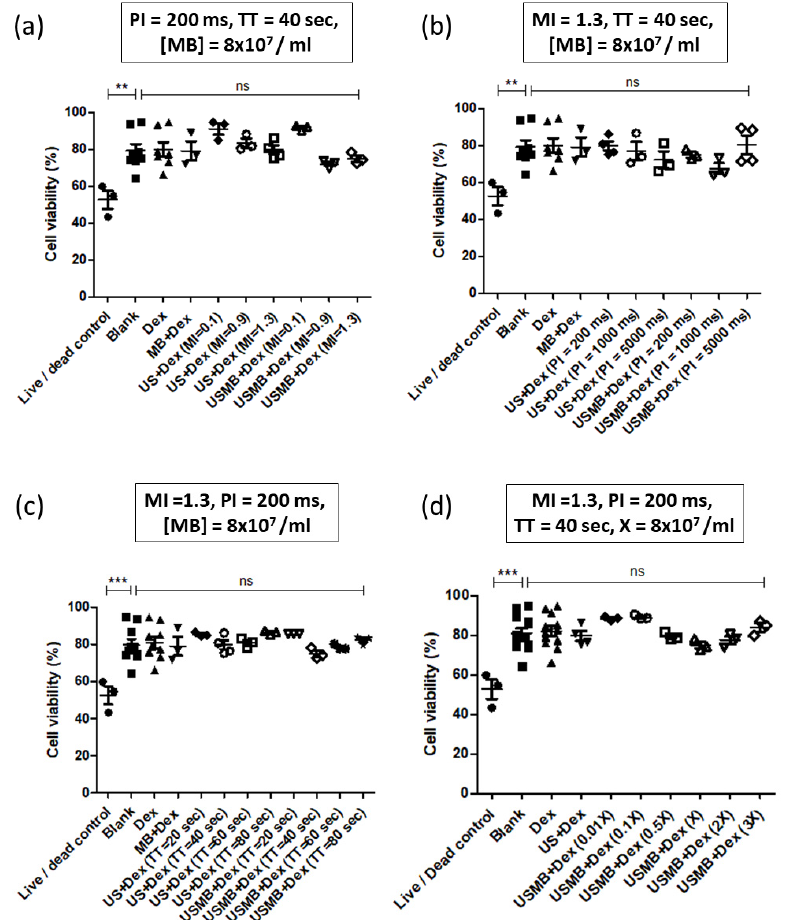
Figure 6. Cell viability of HEK293 cells under different experimental parameters. ( a ) Plot showing cell viability of different treatment groups as MI of ultrasound is varied. There was no significant difference in cell viability across all the groups ( p > 0.05). ( b ) Plot showing cell viability of different treatment groups as the PI of ultrasound was varied. There was no significant difference in cell viability across all the groups ( p > 0.05). ( c ) Plot showing cell viability of different treatment groups as the ultrasound treatment time (TT) was varied. There was no significant difference in cell viability across all the groups ( p > 0.05). ( d ) Plot showing cell viability of different treatment groups, as the microbubble concentration was varied in multiples of X = 8 × 10 7 bubbles/ml. There was no significant difference in cell viability across all the groups ( p > 0.05). In all the experiments, coverslips were incubated for 10 min at 37 °C. One-way ANOVA with post-hoc Tukey’s test was used for assessing statistical significance in all the groups. In all the figures, ** represents p < 0.01 and *** represents p < 0.001.